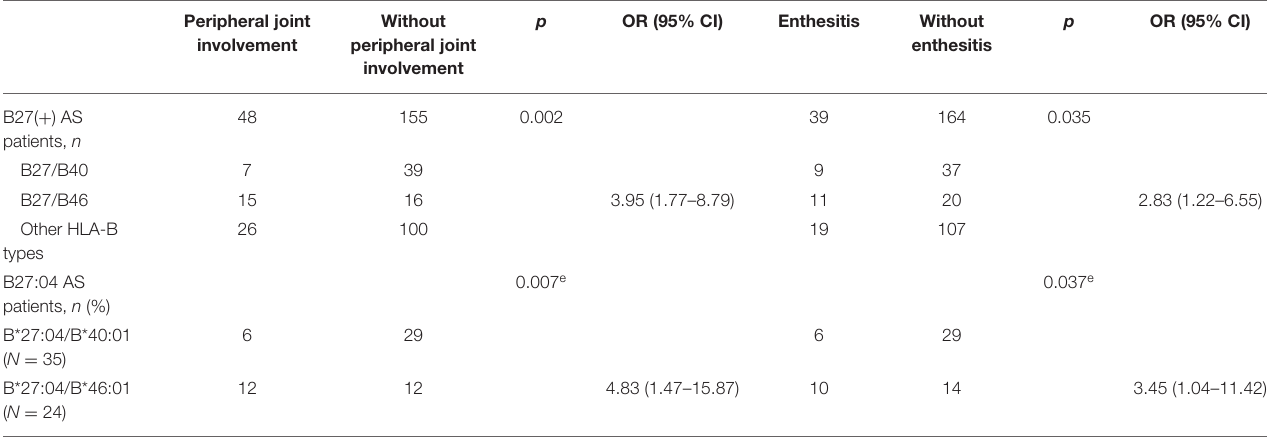
TABLE 5 | Association of HLA-B40 and HLA-B46 with peripheral joint involvement in B27( + ) AS patients (step 2). Peripheral joint